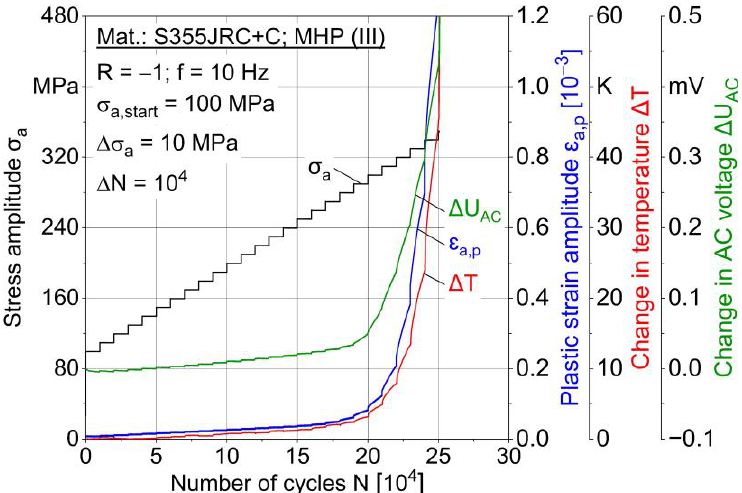
Figure 13. Multiple amplitude test (MAT) for MHP post-treated (III) specimen.